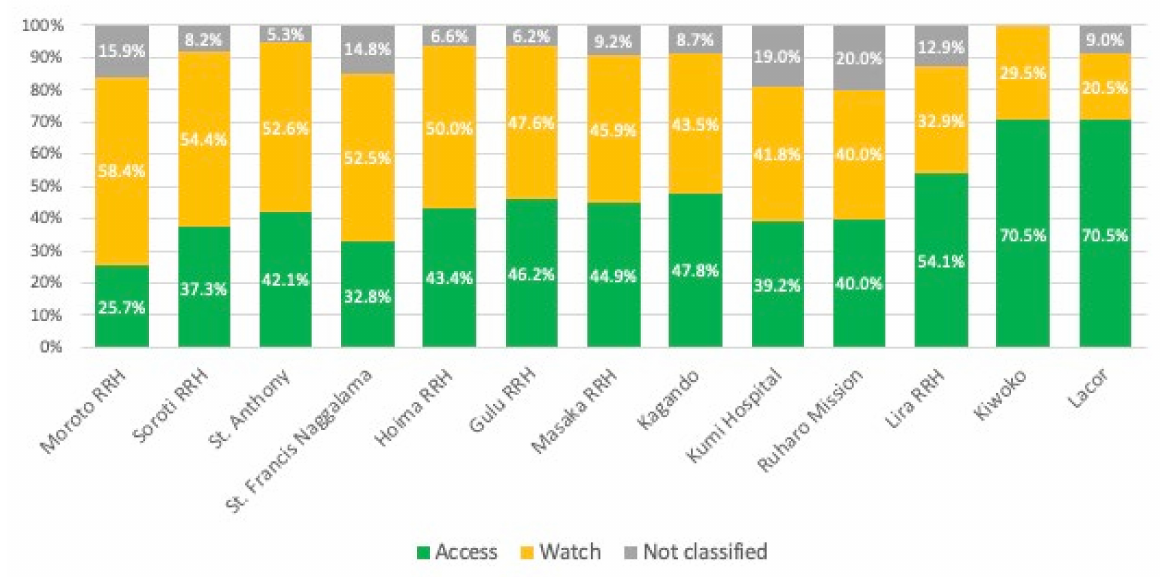
Figure 3. Prescriptions by AWaRe classification per